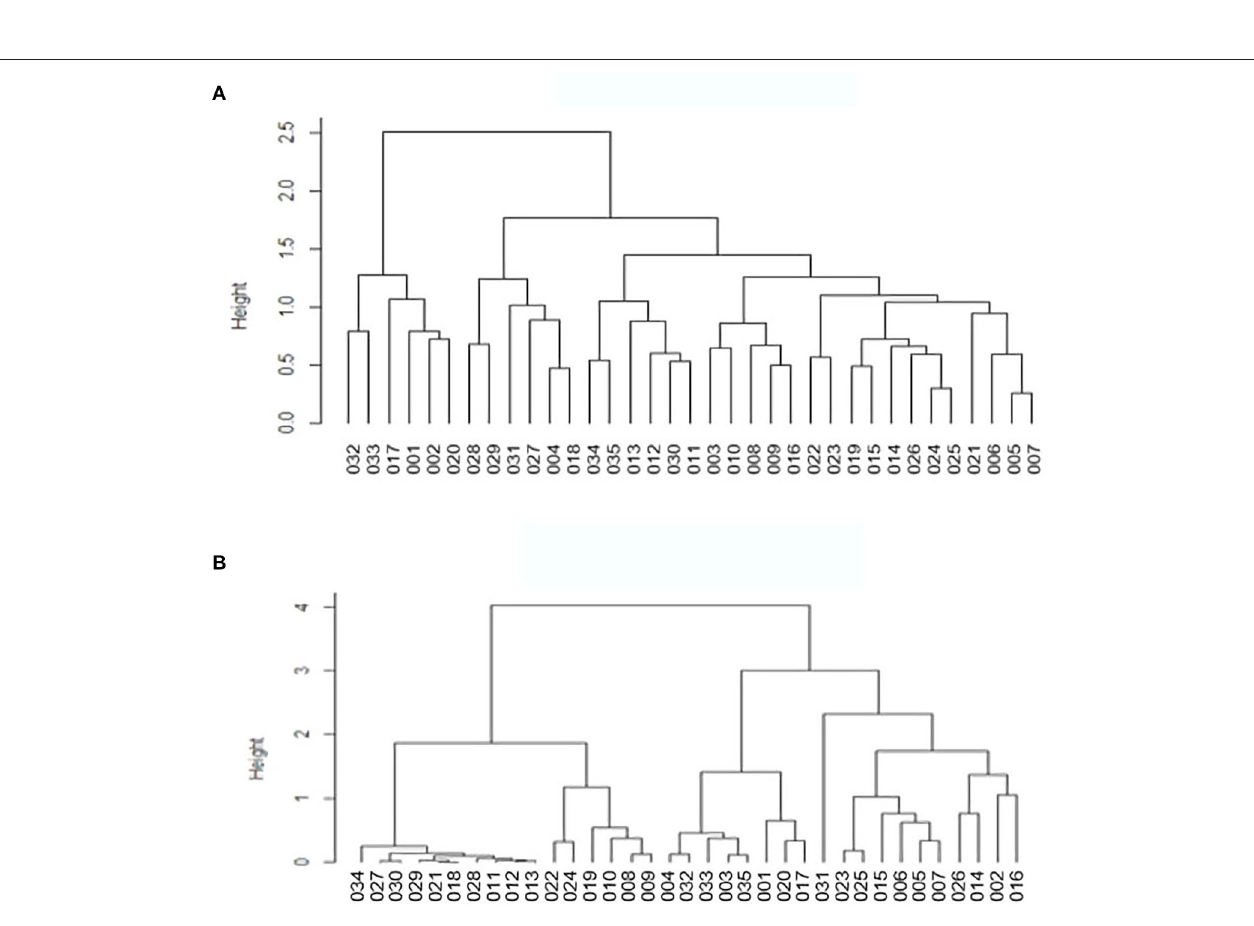
FIGURE 7 | Cluster analysis diagram (A) is unweighted, (B) is